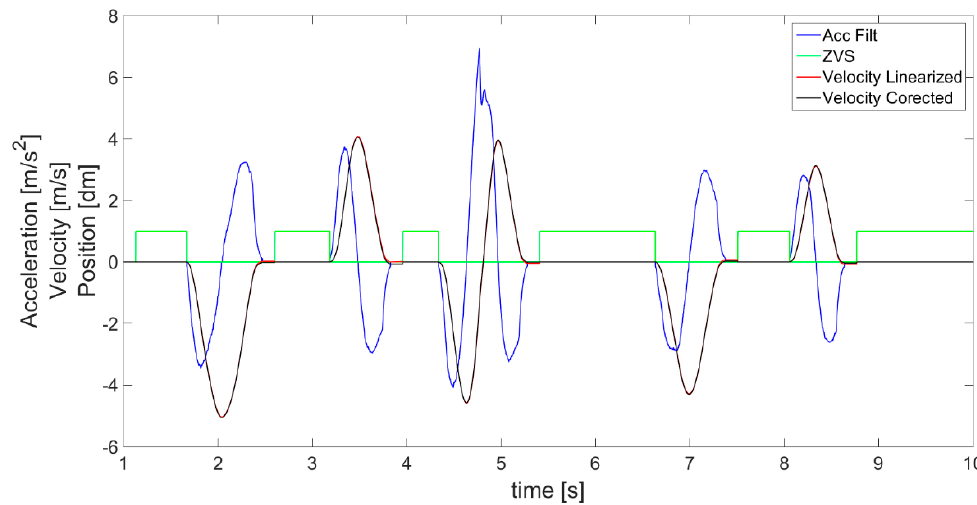
Figure 11. Velocity calculated after acceleration symmetrization (red line—velocity linearized) compared with previous corrected velocity (black line).